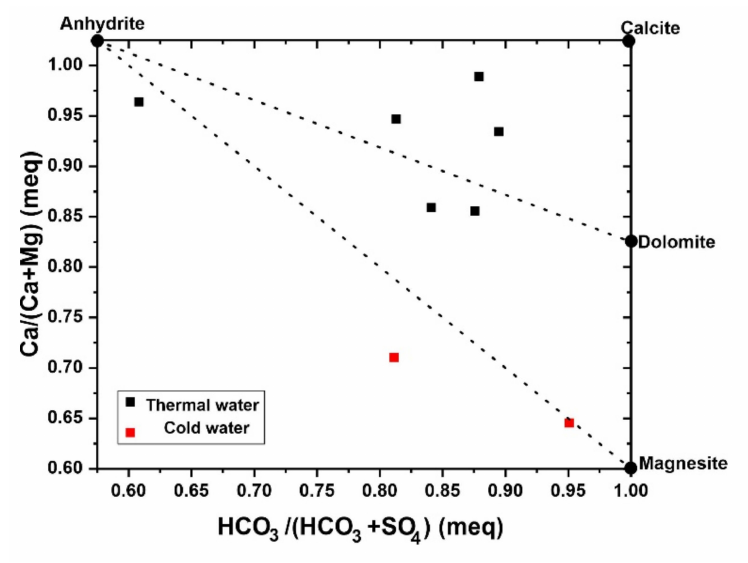
Figure 11. Ca/(Ca + Mg) vs. HCO 3 /(HCO 3 + SO 4 )